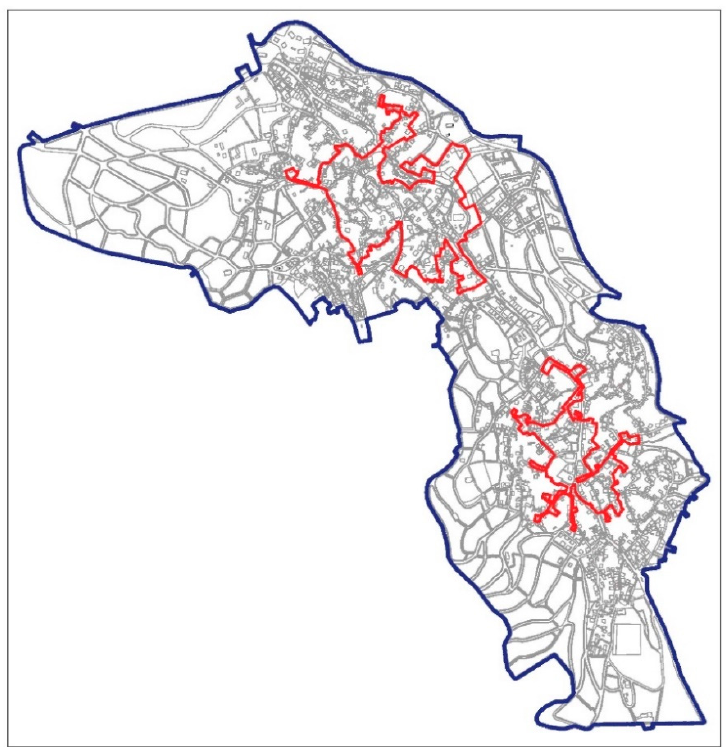
Figure 14. Definition of the limits of the traditional settlement (red) and protection zone (blue).